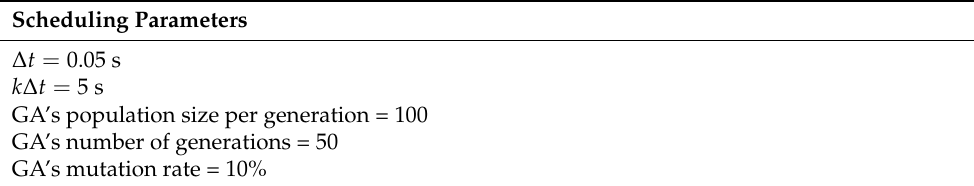
Table 3. Scheduling